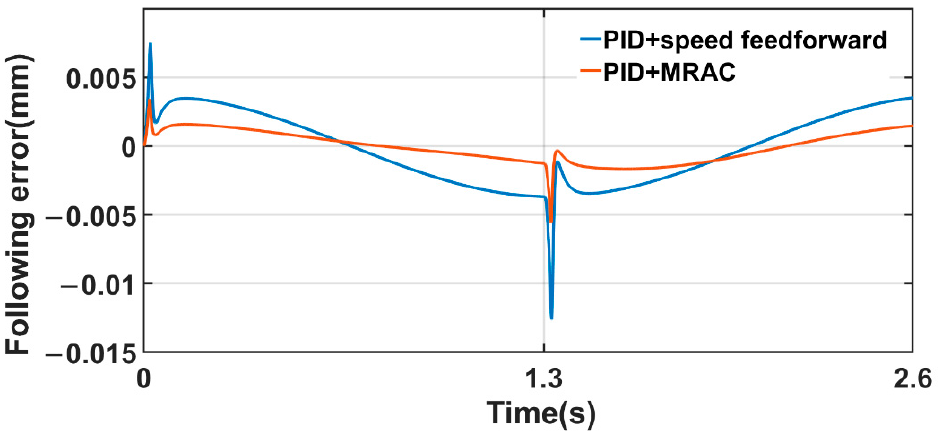
Figure 13. Comparison of the following error of two methods at general machining speed.